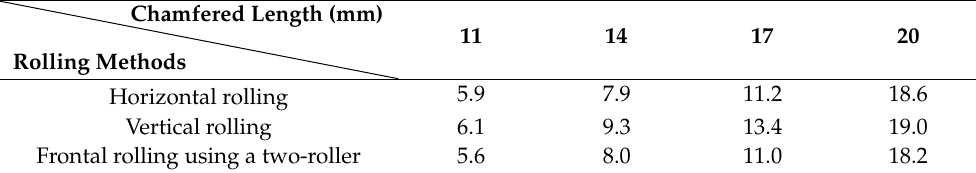
Table 2. Rolling resistance for different rolling methods. (ton).